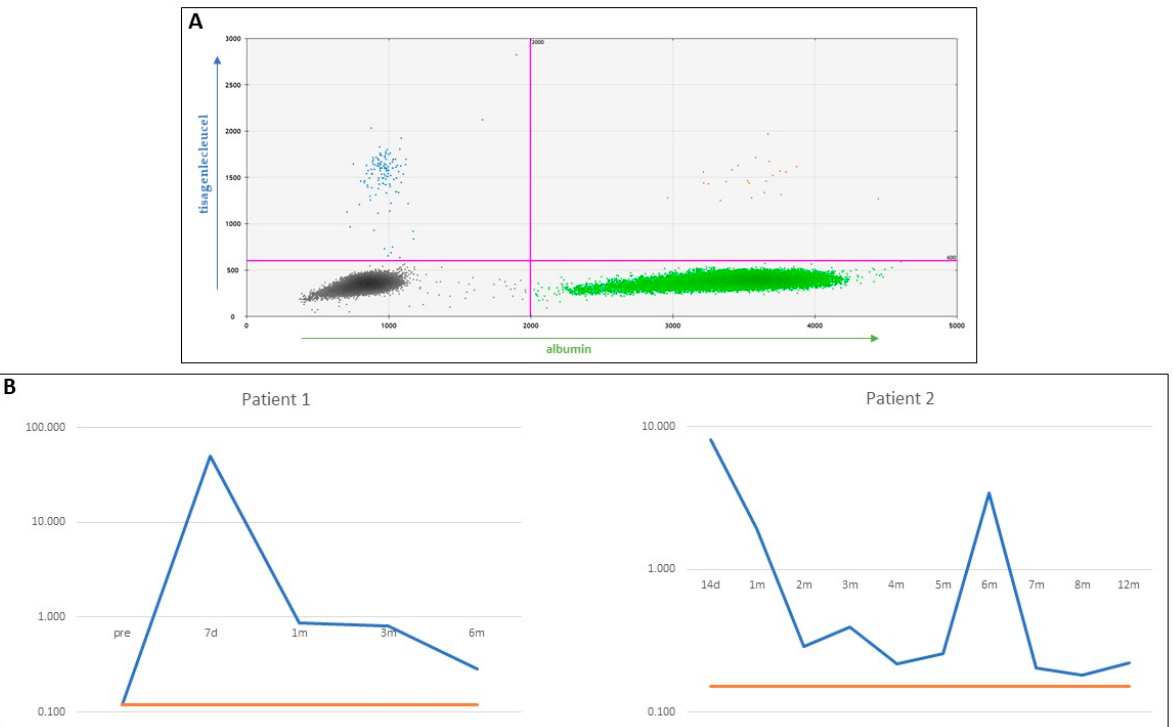
Figure 4. ( A ) A 2D plot showing the 4 quadrants seen in the ddPCR using the QuantaSoft software (Bio-Rad). In the lower left, in black, are the negative events that are always present and in abundance. In the lower right, in green, is the albumin (reference gene). In the upper left, in blue, is the tisagenlecleucel (4-1BB-CAR), and in the upper right, in orange, are the double positive events for both tisagenlecleucel and albumin. The distinction between these populations was clearly visible, allowing for efficient CNV quantification. ( B ) Longitudinal data for patient 1, in log scale, varying from pre-administration of tisagenlecleucel up to 6 months after. The trendline shows the LoQ for this patient’s CAR T levels prior to administration. At 7 days posttreatment, CAR T levels were at the highest level past the LoQ, as expected. The pretreatment sample showed negative CAR T cell levels, also as expected. Also shown are longitudinal data for patient 2, in log scale, from 14 days to a year post-tisagenlecleucel treatment. In this case, CAR T levels never dropped below the LoQ, an indication of good clinical outcome. Raw data can be found in Appendix E.